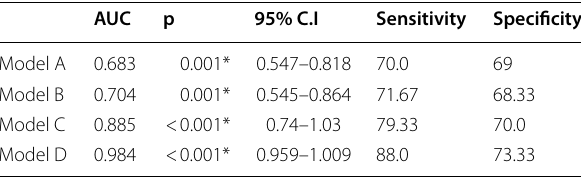
Table 9 Agreement (sensitivity, specificity) for model A, model B, model C and model D to detect/predict obstructive coronary artery disease (> 50%